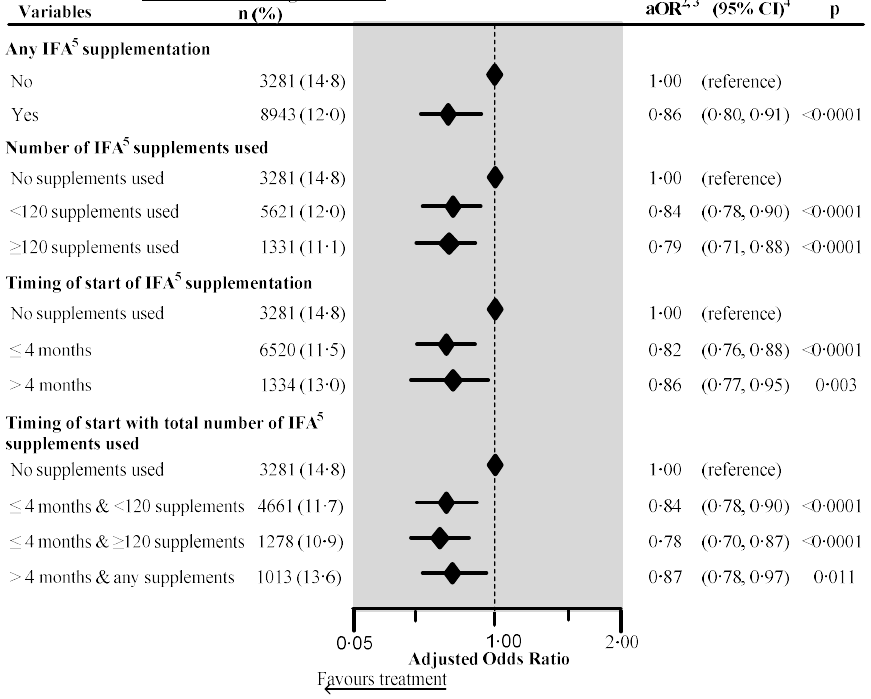
Figure 3. Effect of any iron/folic acid (IFA) supplementation, the number of supplements used, the timing of the start of the supplements and a combination of the timing of start with the number of supplements used on the maternally perceived birth size in four South Asian countries 6 , using adjusted logistic regression. 1 Included smaller than average and smallest categories 2 Adjusted for country, place of residence, maternal marital status, maternal educational status, maternal working status, paternal educational status, paternal working status, fuel used for cooking, source of drinking water, sanitation facilities, pooled household wealth index, maternal age at childbirth, maternal desire for pregnancy, maternal smoking status, maternal height, birth outcome status, birth interval and rank, and sex of child. Also, we adjusted the model for the duration of recall. 3 aOR: Adjusted odds ratio. 4 CI: Confidence interval. 5 IFA: Iron/folic acid. 6 The surveys from India, Maldives, Nepal, and Pakistan collected information on maternally perceived birth size. We excluded records of mothers from analysis who reported consumption of >240 IFA supplements during pregnancy. We also excluded those records where the number of supplements consumed exceeded the number possible when supplementation started between the fifth and ninth months of pregnancy.